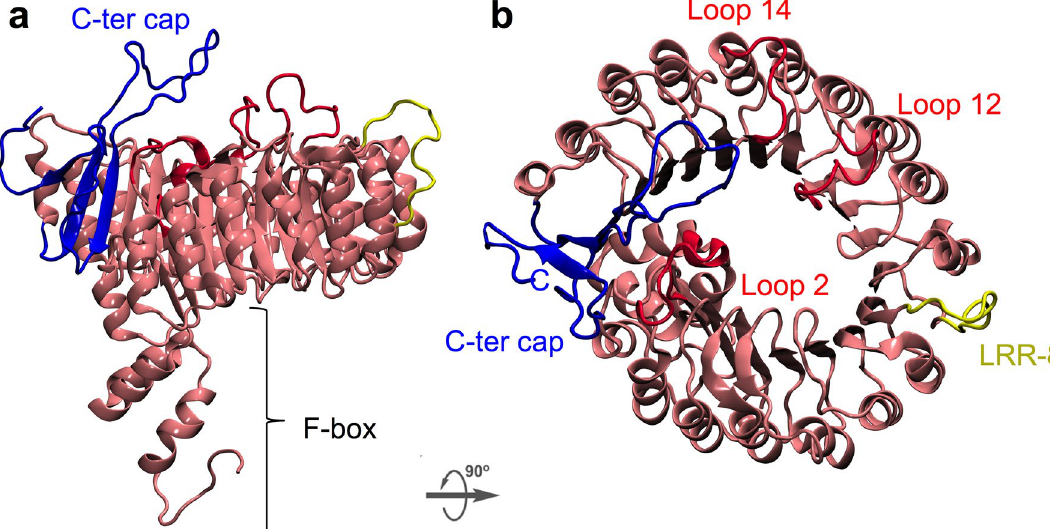
Figure 3. The structural model for FaCOI1. The structural model for FaCOI1 is shown as a New Cartoon representation with front ( a ) and top ( b ) views. The pink color showed the F-box and LRR domains, meanwhile in yellow color LRR-8 domain is represented. In blue color, the C-terminal is shown, and three important loops forming the JA-Ile pocket are shown in red color. Fa, Fragaria × ananassa ; COI1, CORONATINE